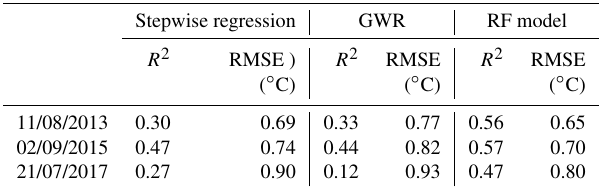
Table 4. Importance of input variables for the RF model of AT esti- mation on the three different days. Date format: